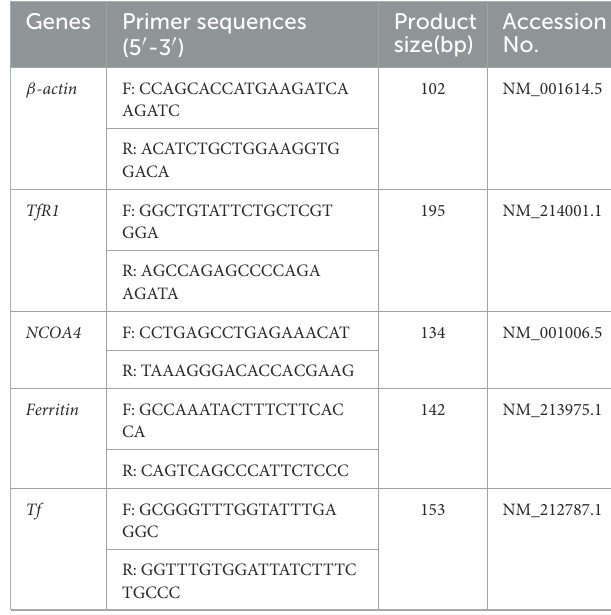
TABLE 1 Composition and nutrient levels of the basal diets (as-fed basis). TABLE 2 The information of PCR primers.